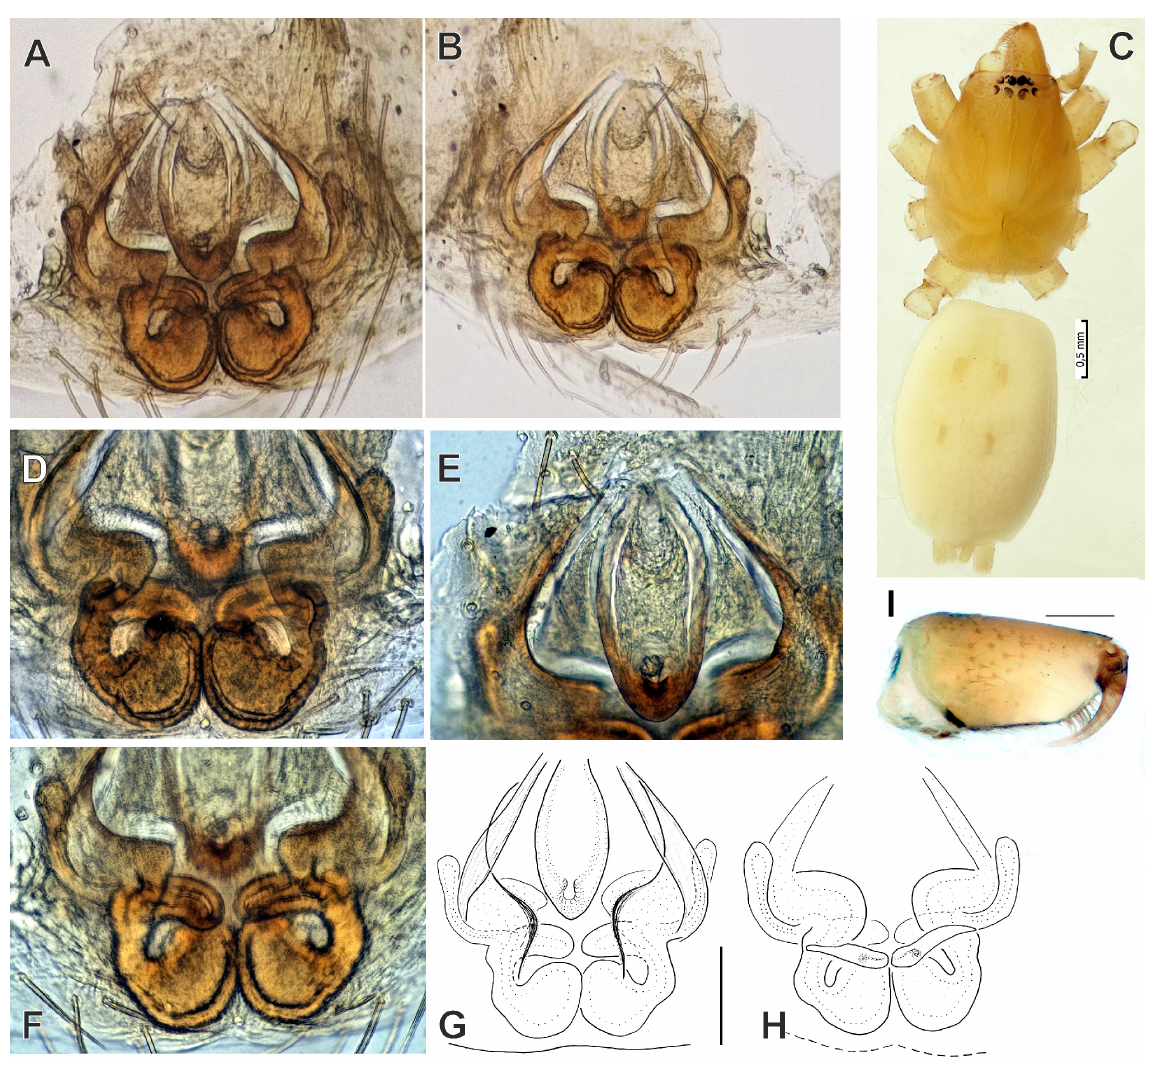
Fig. 21. Sosticus montanus sp. nov., holotype, ♀ (MHNG). A, E, G . Epigyne, ventral view. B, D, F, H . Epigyne, dorsal view. C . Habitus, dorsal view. I . Chelicera, posterior view. Scale bars: C = 0.5 mm; G–H = 0.1 mm; I = 0.2